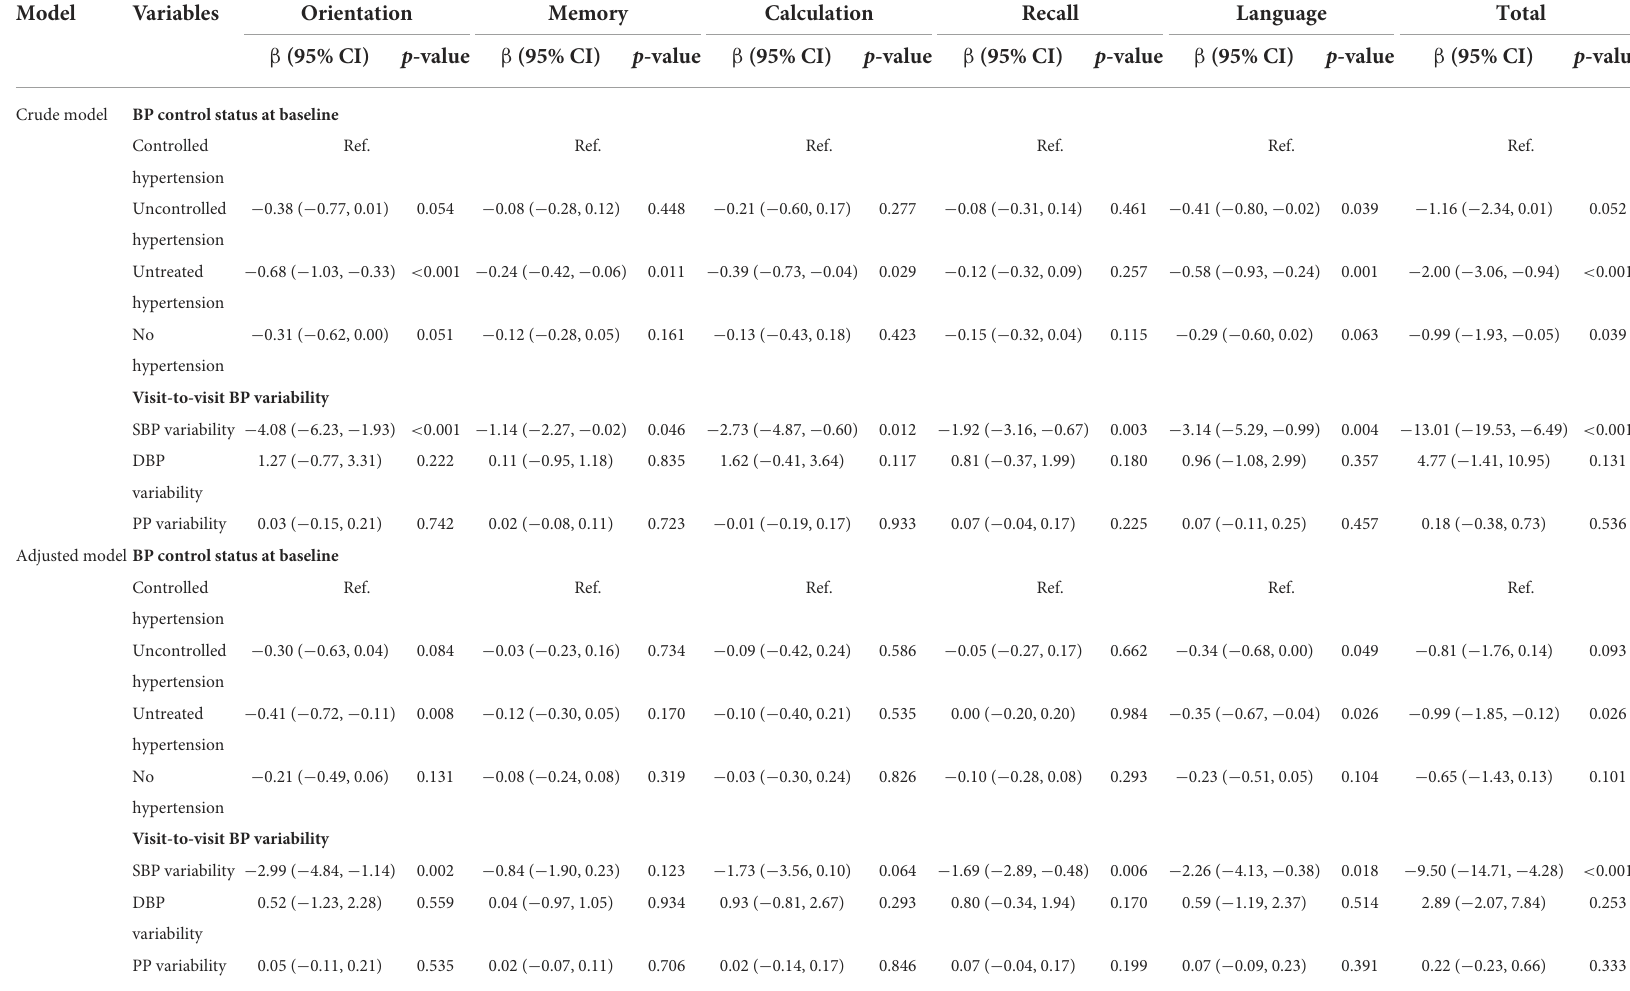
TABLE 3 General linear model for association between BP control status at baseline, visit-to-visit BP variability and cognitive scores in the old-old group. Model Variables Orientation